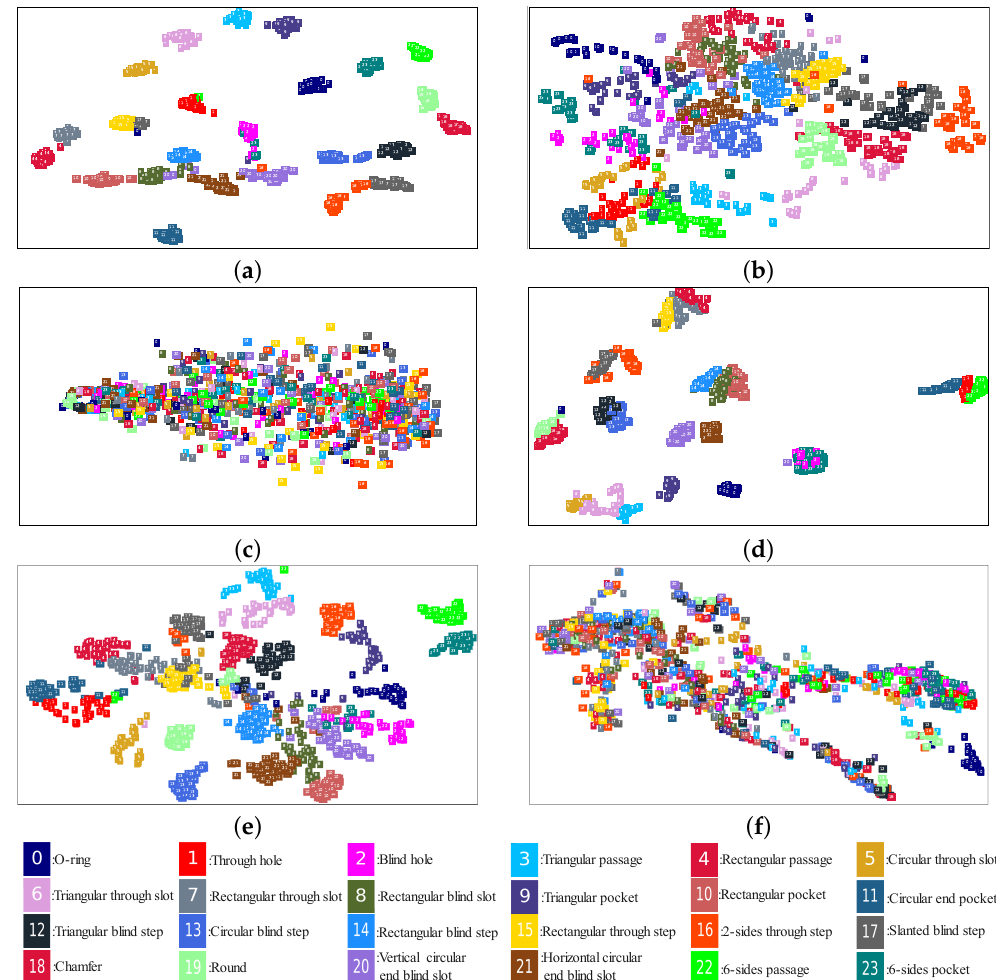
Figure 9. The t-SNE visualization of the visual representation on test set: ( a ) the backbone output of MsvNetLite after fine-tuning using the SGDM optimizer in semi-supervised learning, ( b ) the backbone output of MsvNetLite initialized with ImageNet pre-trained weights, ( c ) the backbone output of MsvNetLite with random initialization, ( d ) the backbone output of MsvNetLite after the self- supervised stage in semi-supervised learning, ( e ) the backbone output of MsvNetLite after supervised learning, ( f ) the backbone output of MsvNetLite after fine-tuning using the Adam optimizer in semi- supervised